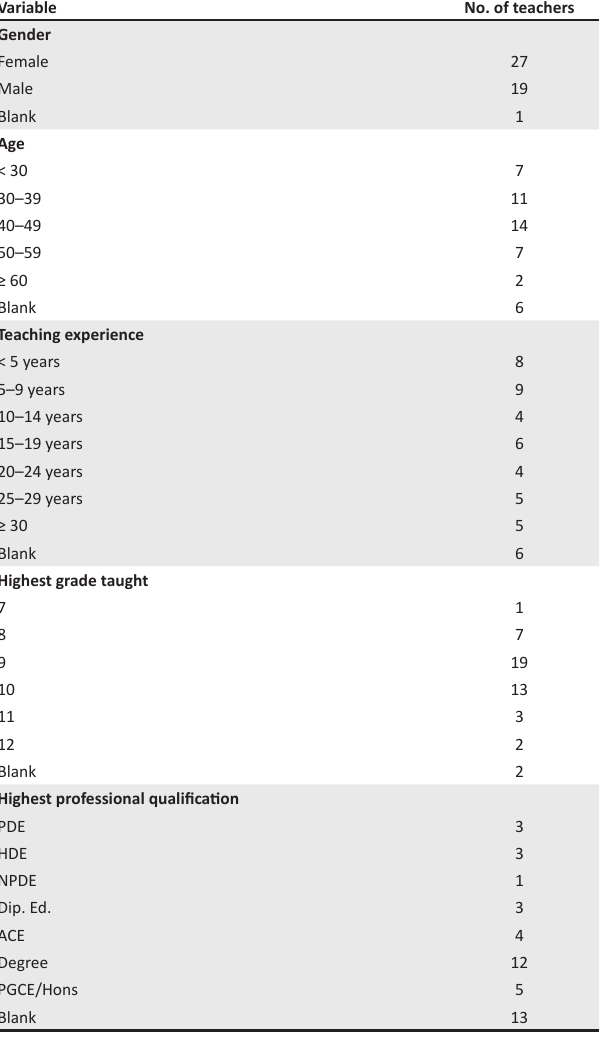
TABLE 1: Demographic